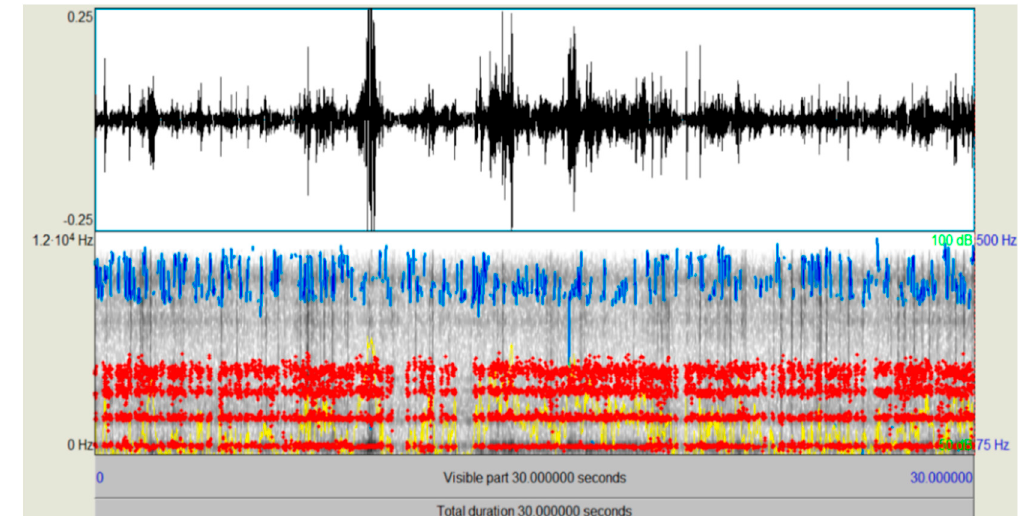
Figure 6. Spectrogram of the audio signal “Very heavy rain”.